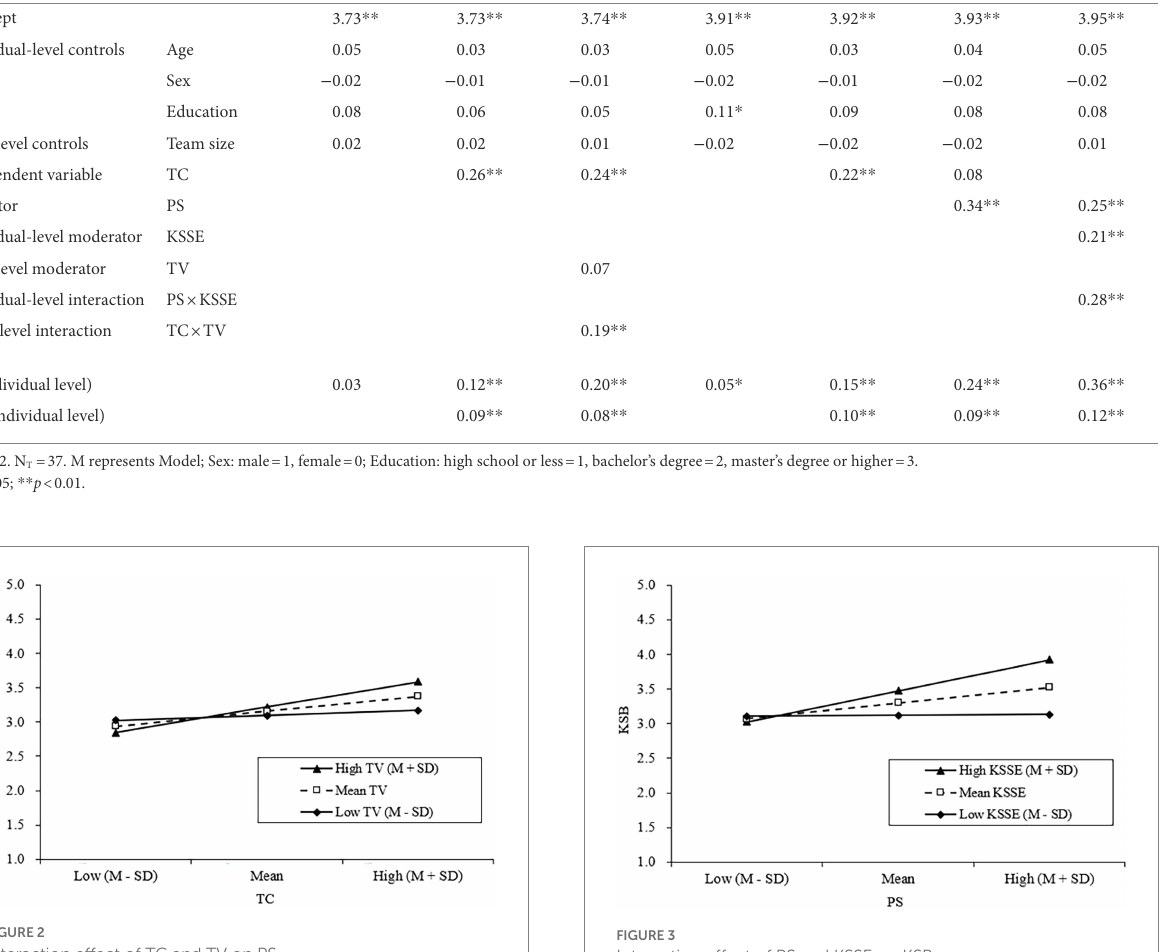
FIGURE 3 Interaction effect of PS and KSSE on